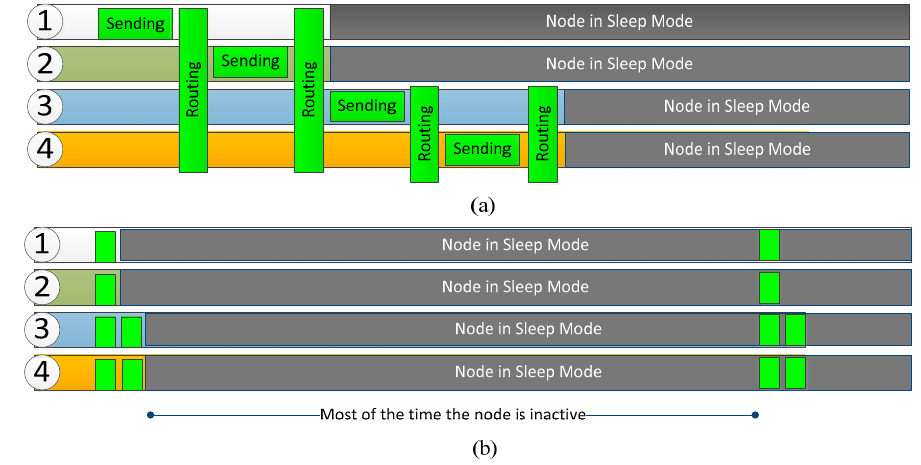
Figure 5. ( a ) Data sending spread out in intervals; ( b ) Power saving mechanism.